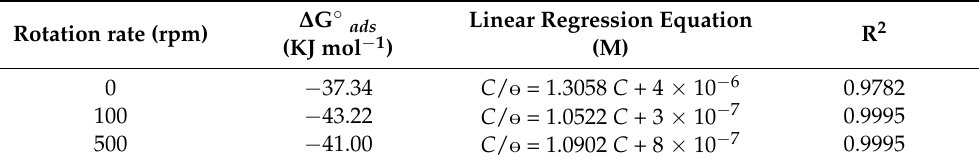
Table 2. Thermodynamic analysis of 4-PC immersed in 3% NaCl + CO 2 in 1018 steel at different rotation rates by means of the Langmuir model.